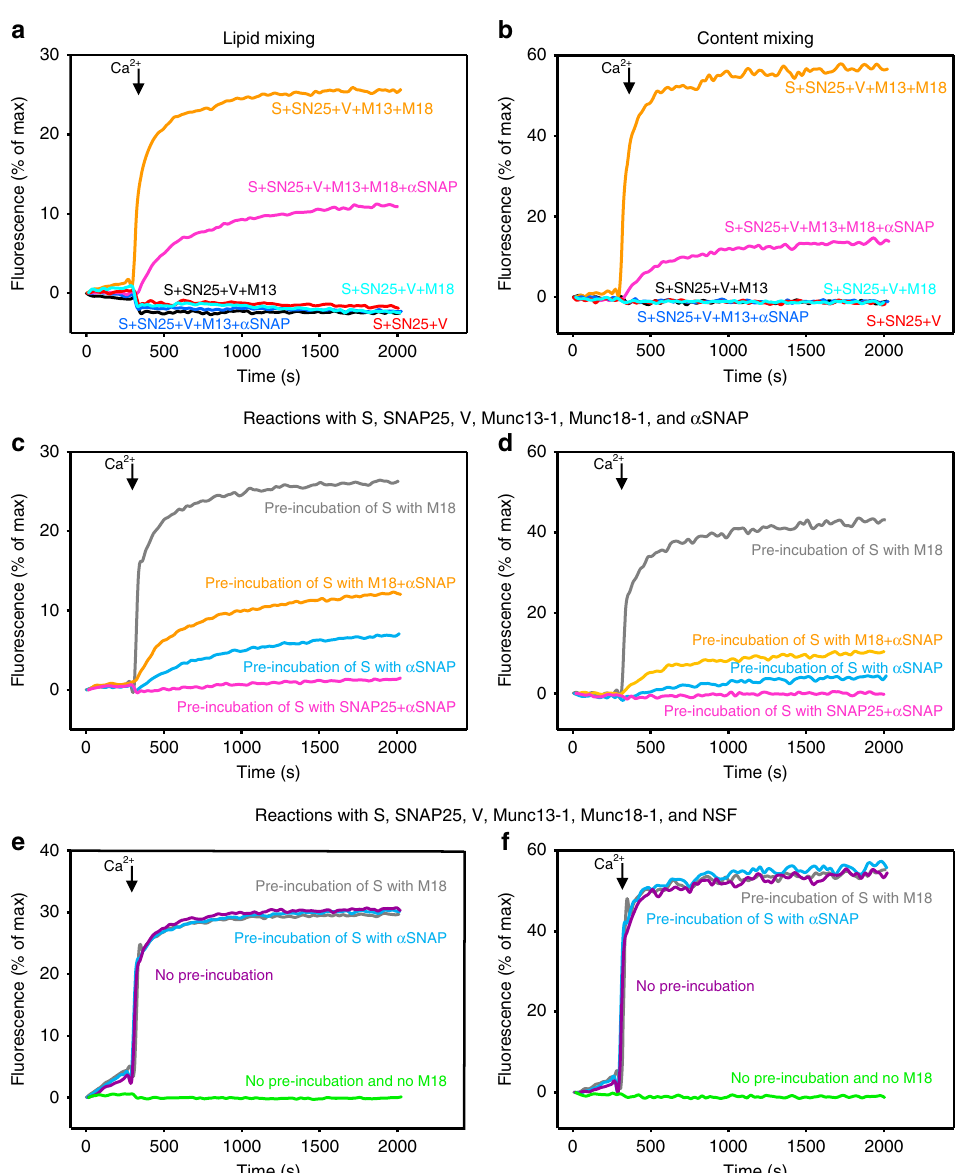
Fig. 7 Binding of Munc18-1 to syntaxin-1 overcomes the inhibition of fusion caused by α SNAP. a – f Lipid mixing ( a , c , e ) between V- and S-liposomes was monitored from the fl uorescence de-quenching of Marina Blue lipids and content mixing ( b , d , f ) was monitored from the increase in the fl uorescence signal of Cy5-streptavidin trapped in the V-liposomes caused by FRET with PhycoE-biotin trapped in the T-liposomes upon liposome fusion. In a , b , all assays were performed in the presence of 1 µ M SNAP-25 plus different combinations of 0.5 µ M M13C 1 C 2 BMUNC 2 C (M13), 1 µ M Munc18-1 (M18), and 2 µ M α SNAP. In c , d , all assays were performed in the presence of 1 µ M SNAP-25, 0.5 µ M M13C 1 C 2 BMUNC 2 C (M13), 1 µ M Munc18-1 (M18), and 2 µ M α SNAP, but pre-incubating the S-liposomes with different reagents as indicated. In e , f , all assays were performed in the presence of 0.8 µ M NSF, 1 µ M indicated. Source data are provided as a Source Data fi